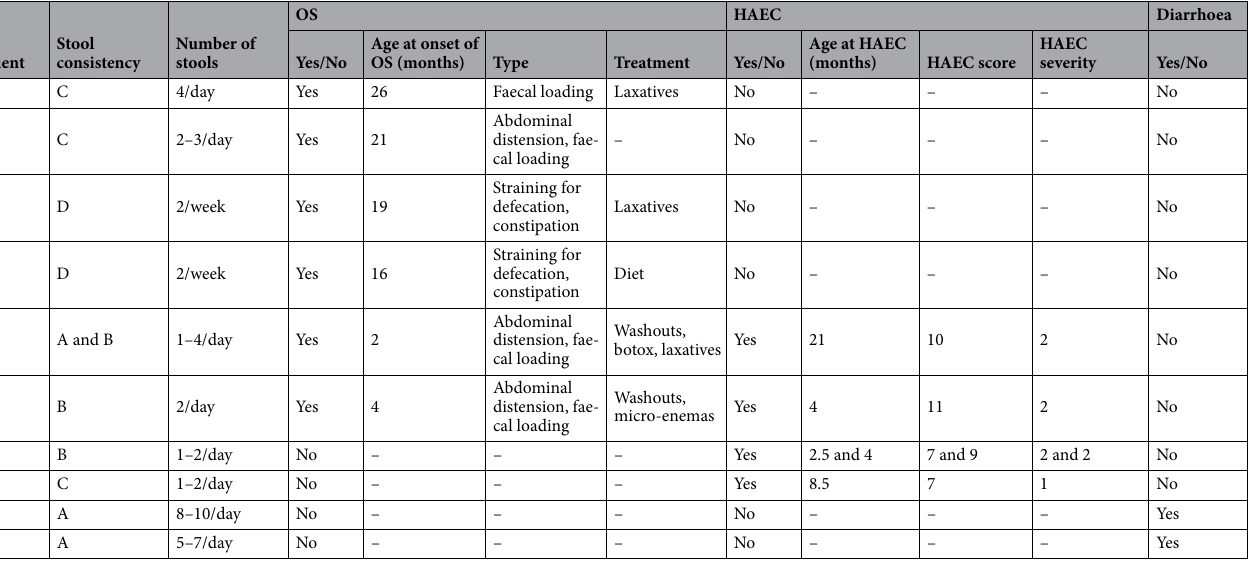
Table 1. Postoperative complications in HSCR patients and age of onset: obstructive symptoms (OS), Hirschsprung-associated enterocolitis (HAEC) and diarrhoea. The treatment received in case of OS was